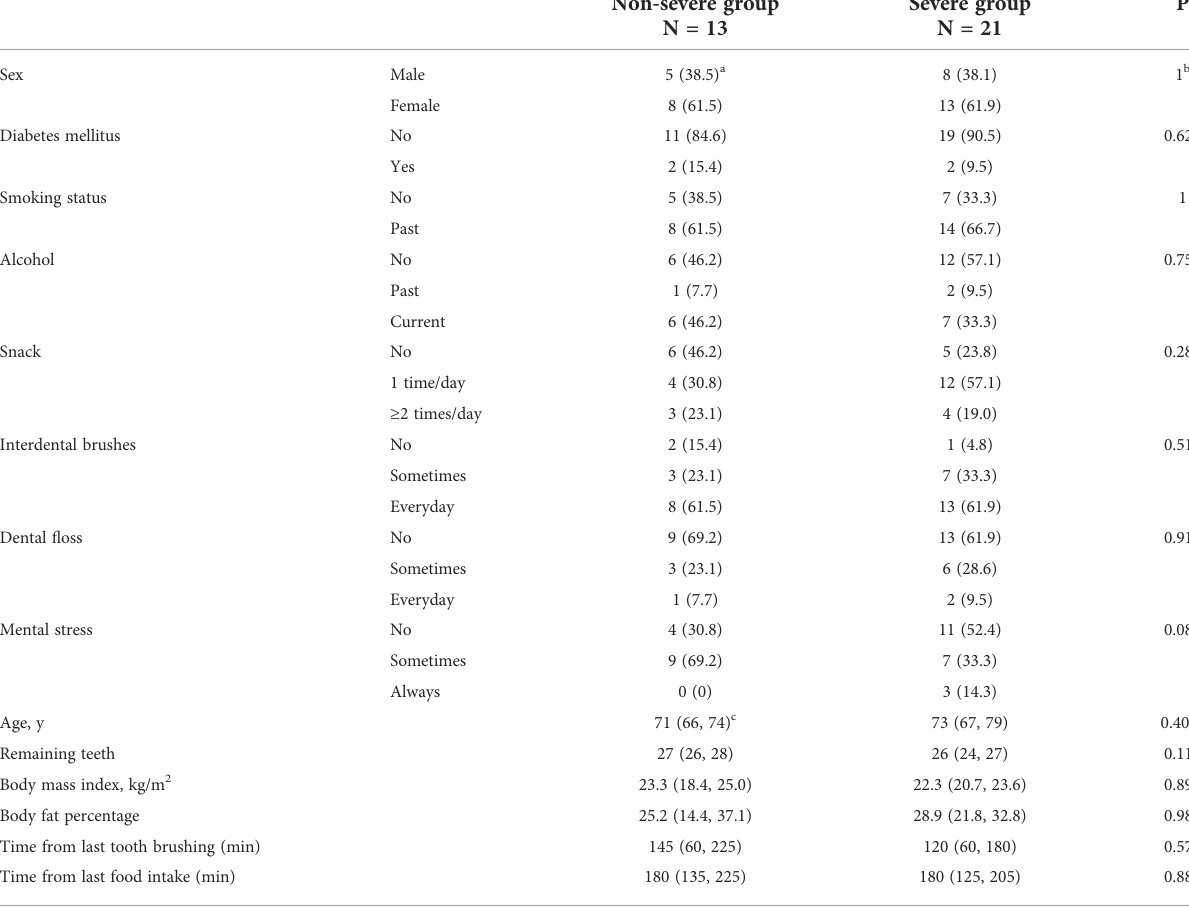
TABLE 1 Differences in parameters between the non-severe and severe